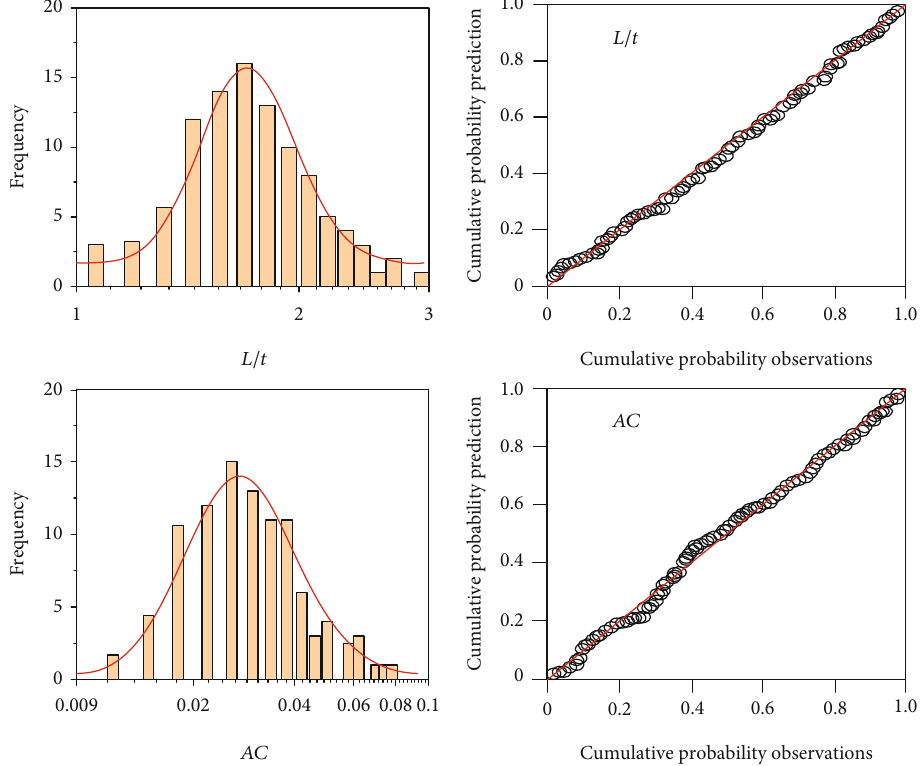
Figure 6: Frequency histogram and lognormal distribution P ‐ P fi gures of L / t and AC